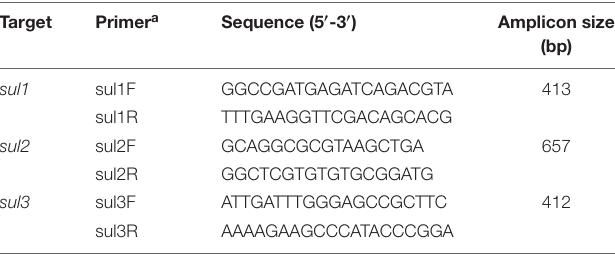
TABLE 2 | Primers and PCR amplification conditions for detection of sul1 , sul2, and sul3 genes.